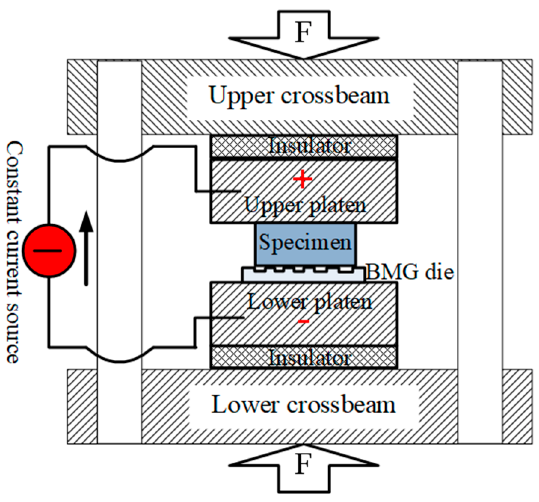
Figure 5. Schematic illustration of the electrically assisted (EA) micro-embossing system.